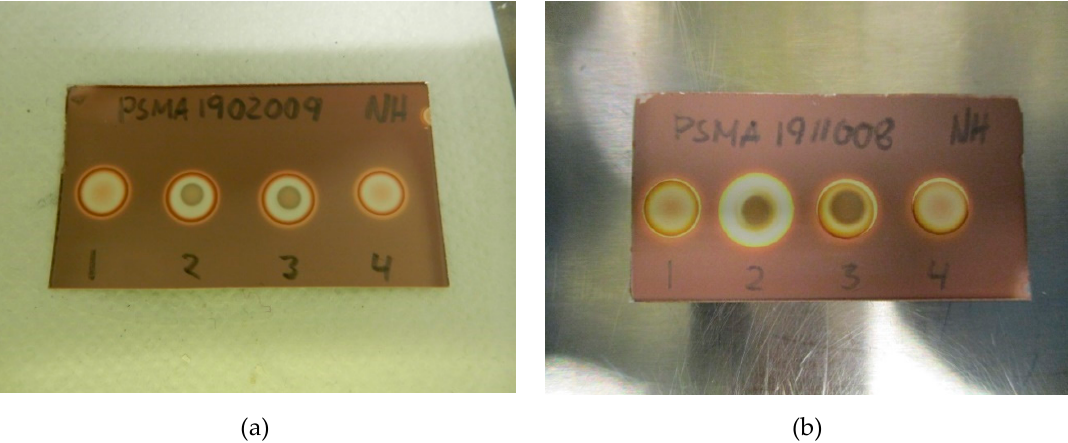
Figure 2. ( a ) Specificity without antioxidant: (1) [ 18 F]PSMA-1007 + water, (2) TBA standard (0.26 mg / mL) + [ 18 F]PSMA-1007, (3) TBA standard (0.26 mg / mL) + water, (4) matrix + water. ( b ) Specificity with antioxidant: (1) [ 18 F]PSMA-1007 + H 2 O 2 , (2) TBA standard (0.26 mg / mL) + [ 18 F]PSMA-1007 + H 2 O 2 , (3) TBA standard (0.26 mg / mL) + H 2 O 2 , (4) matrix + H 2 O 2 .